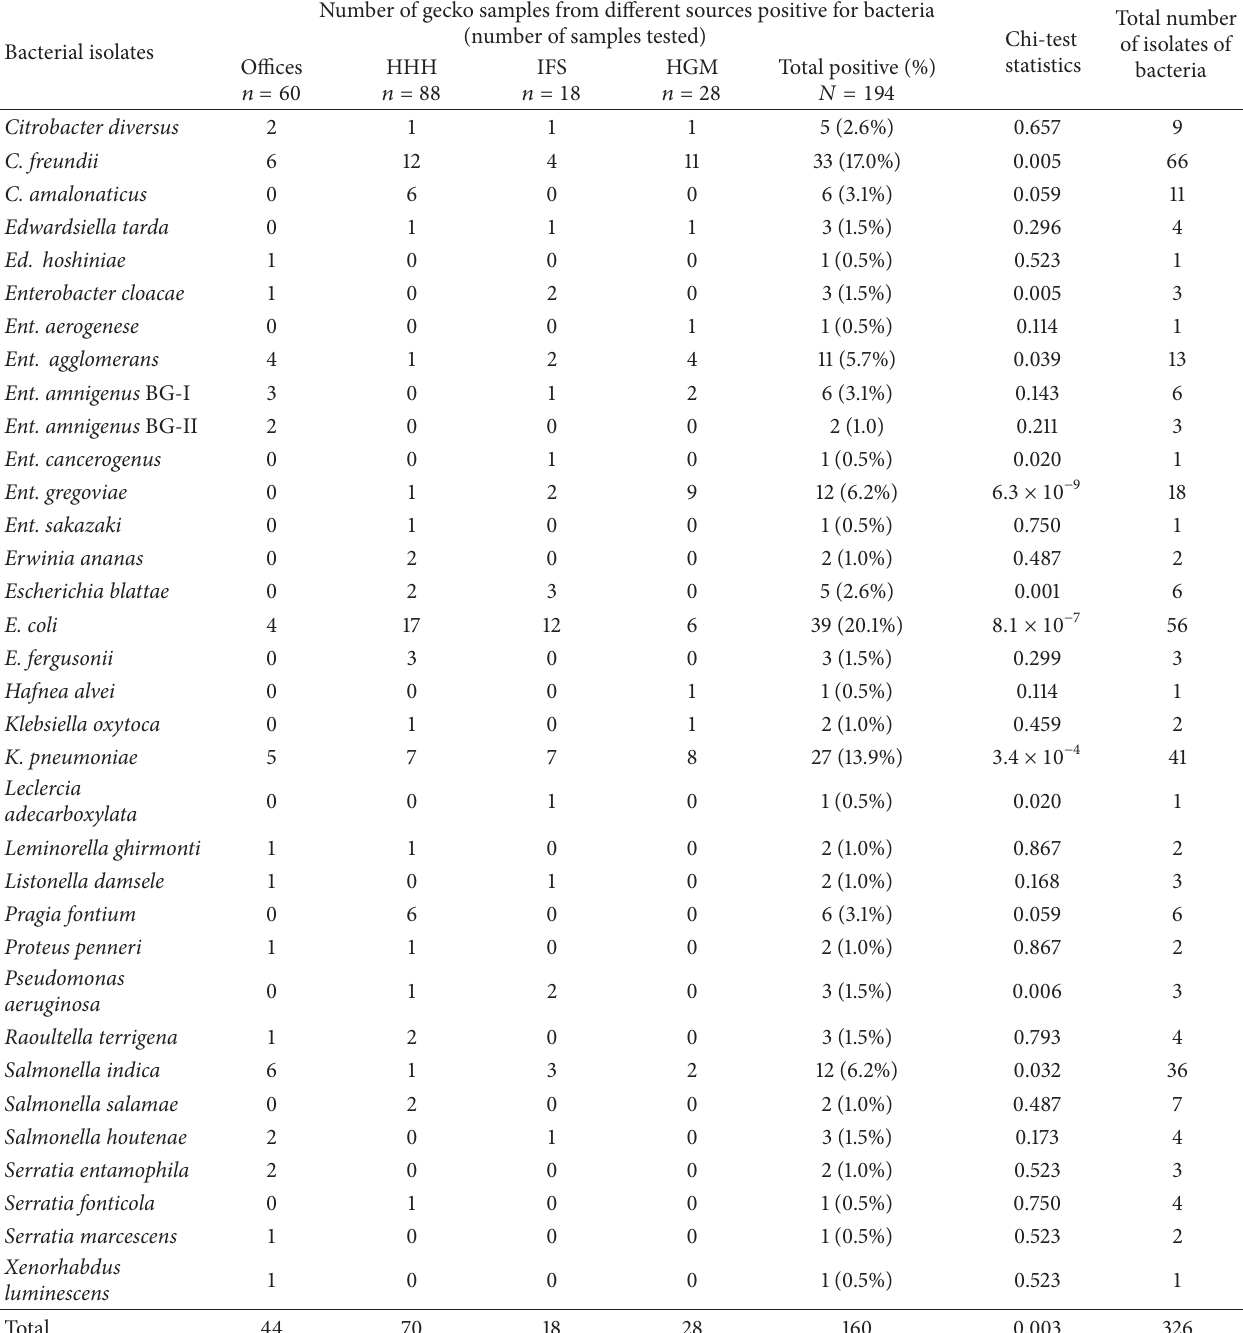
Table 1: Bacterial isolates from faecal droppings of geckos collected from different sources.